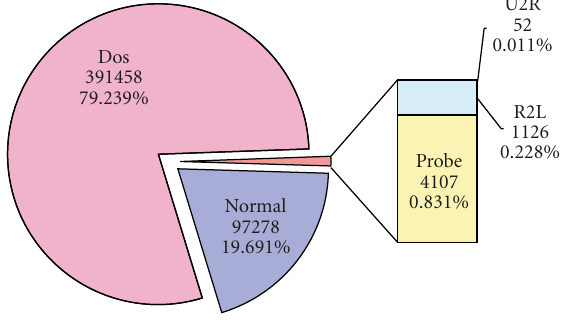
Figure 4: Distribution for the DARPA training